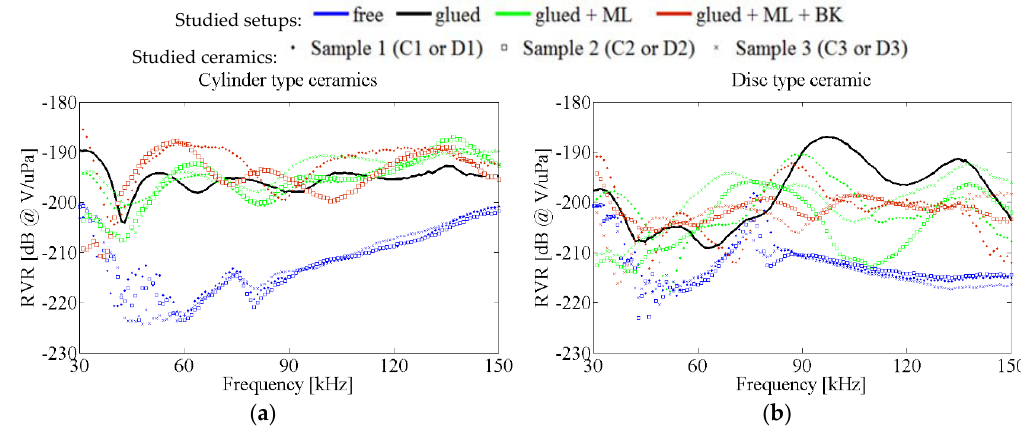
Figure 21. Acoustic sensitivity of all measured ceramics, with and without ML and BK. ( a ) Cylinder type ceramic; ( b ) Disc type ceramic.